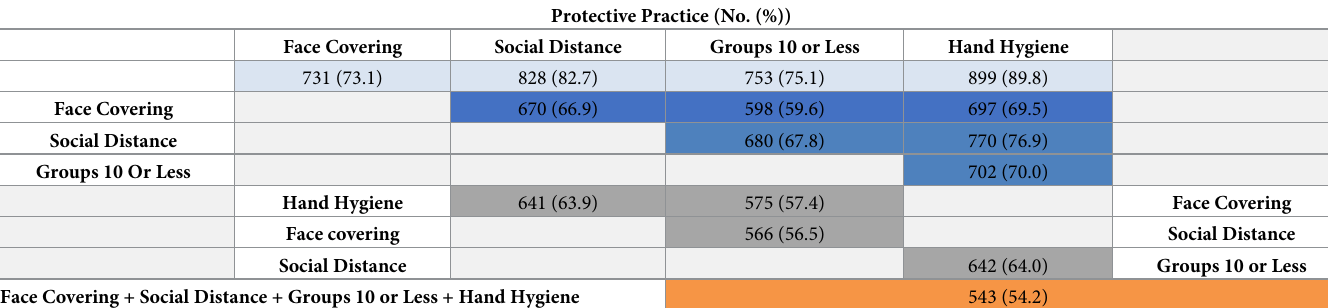
Table 2. Overlap of protective practices among respondents.